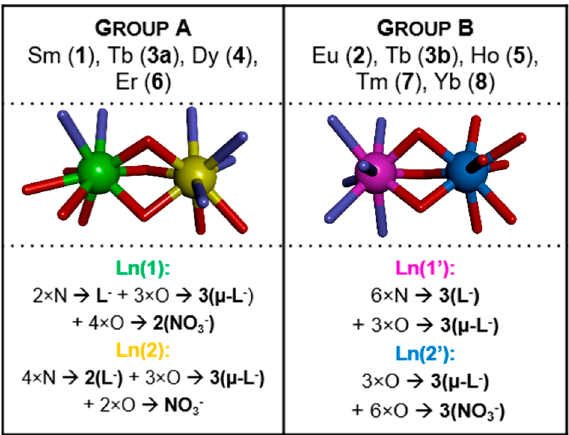
Scheme 1. Schematic representations of the two types (groups A and B) of a coordination patterns of metal ion centers.